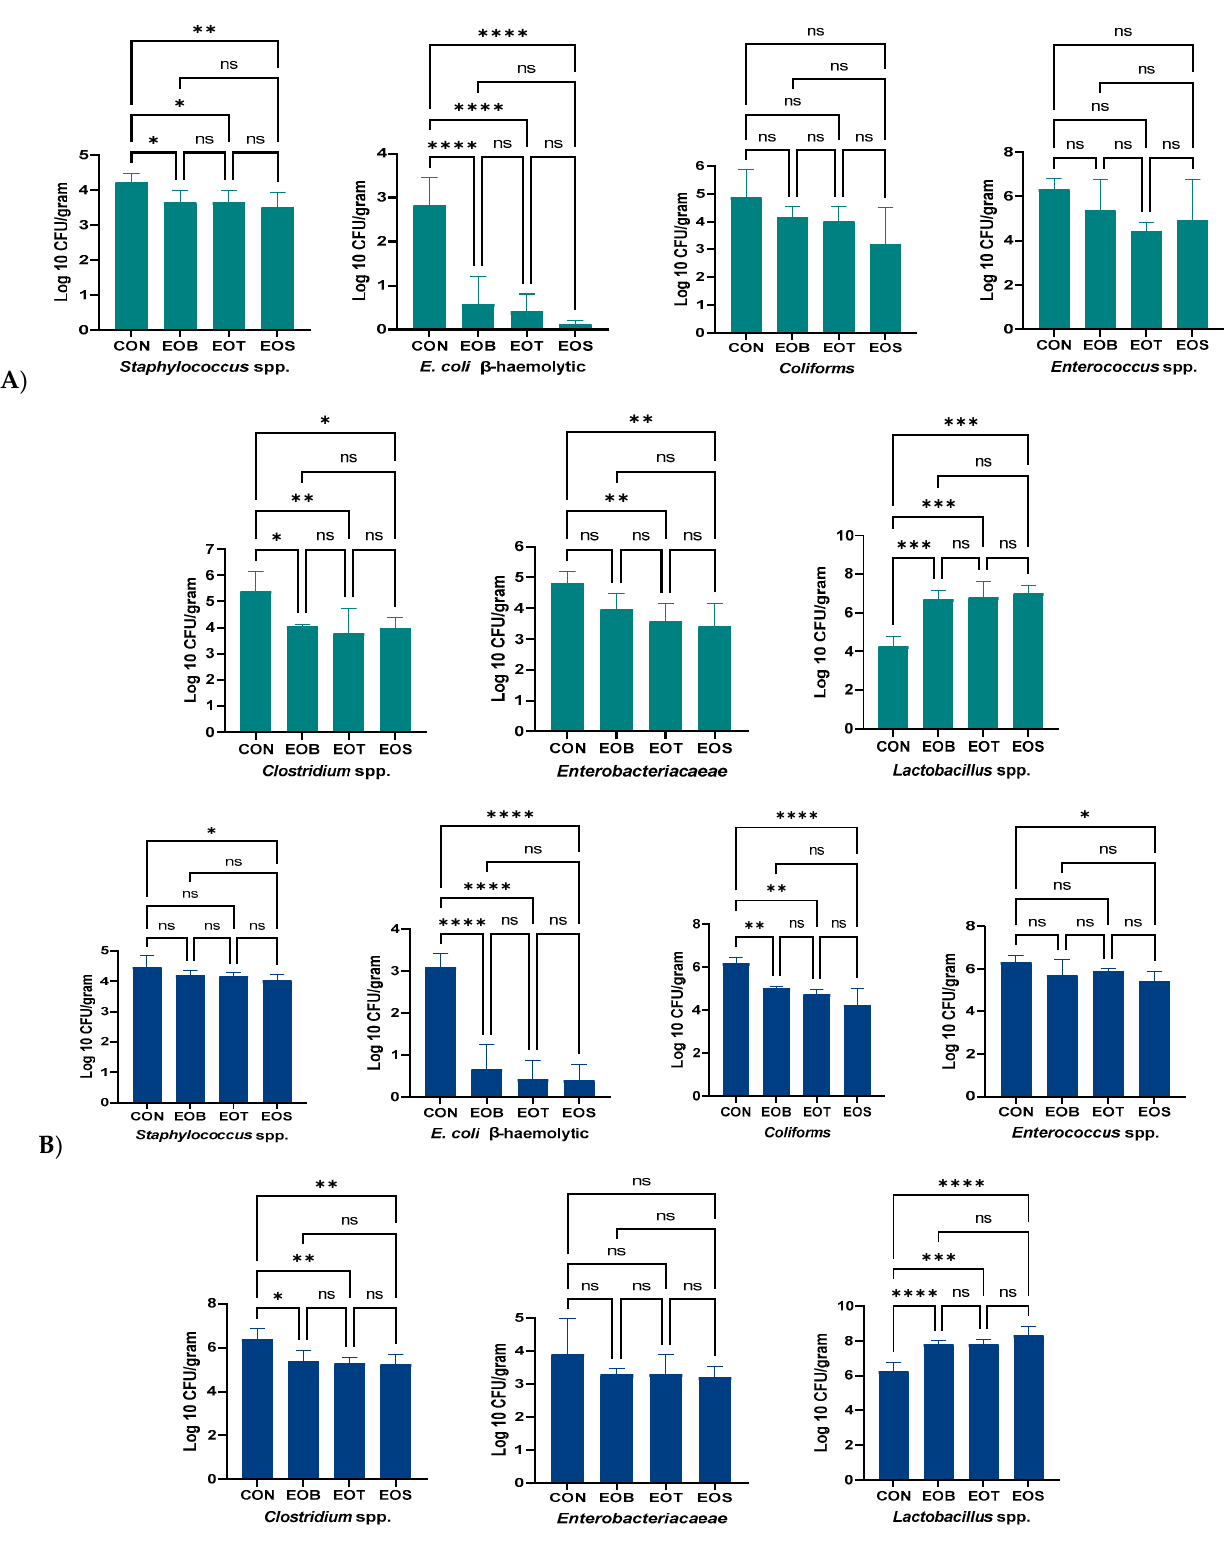
Figure 2. Effect of dietary EO supplements on the intestinal microbiota of broiler chickens deter- mined from ( A ) small intestine segment and ( B ) caecum segment. The results are expressed as (Log10 CFU/g). CON—control diet; EOB—diet containing 0.05% essential oil of basil; EOT—diet containing 0.05% essential oil of thyme; EOS—diet containing 0.05% essential oil of sage. * p < 0.05, ** p < 0.001, *** p < 0.0001, **** p < 0.00001. ns—not